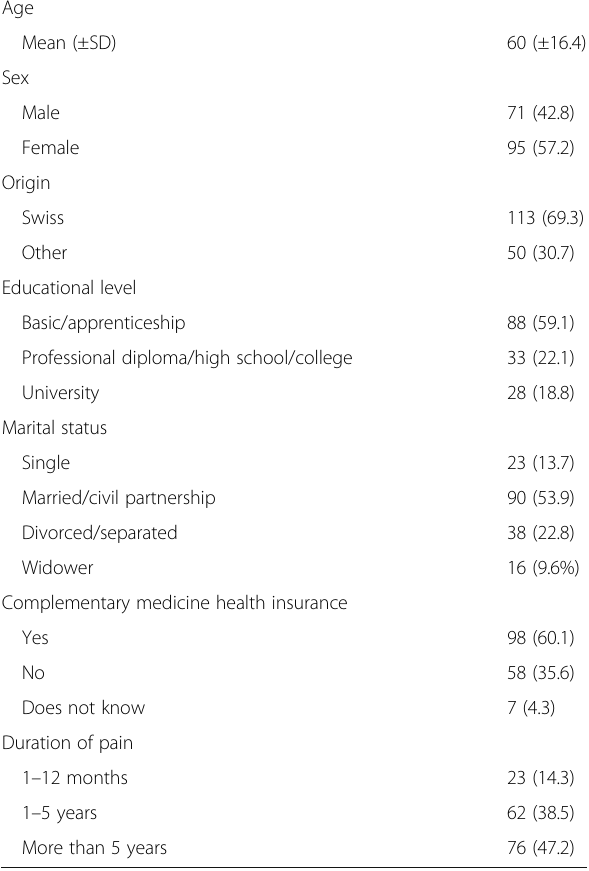
Table 1 Patients ’ socio-demographic characteristics ( N =